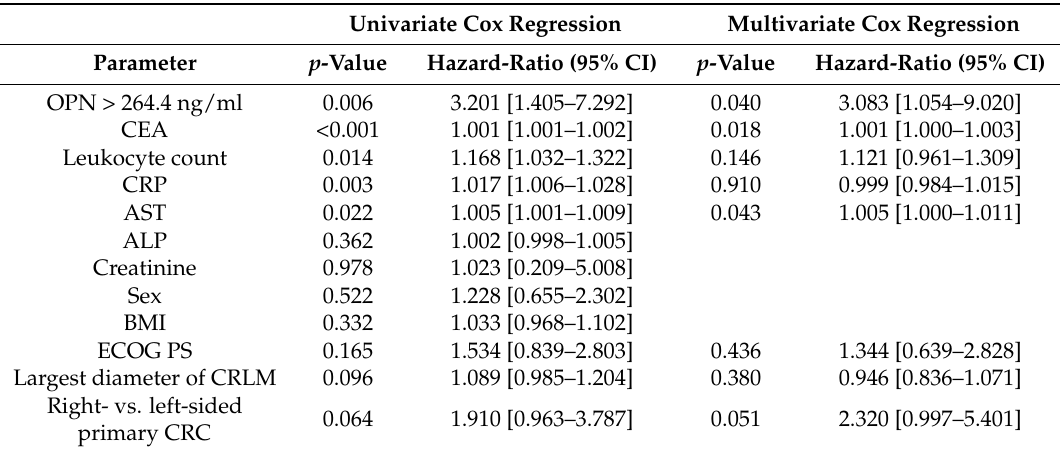
Table 2. Uni- and multivariate Cox regression analyses for the prediction of overall survival. Univariate Cox